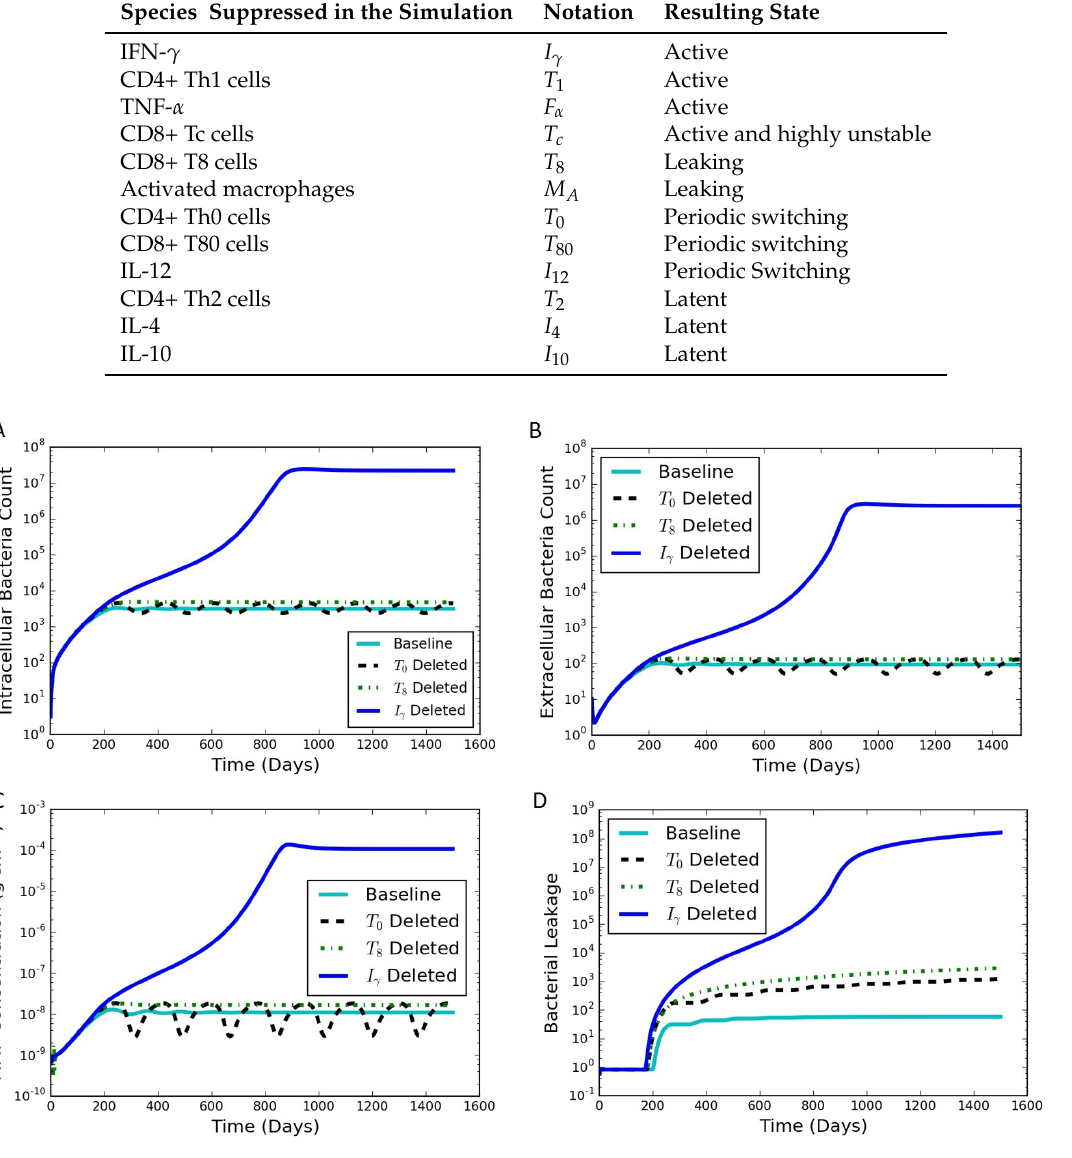
Figure 7. Simulation results of the immune system pertubation experiment where the differential equation corresponding to each of the species shown is set to be zero from day 0, one at a time while the other species follow the otherwise unmodified model equations. Perturbed responses are shown for T 0 , T 8 , and I γ (dashed, dotted, and dark solid lines, respectively) The baseline is considered to be a steady latent state (light solid line). ( A ) intracellular bacterial count vs. time; ( B ) extracellular bacterial count vs. time; ( C ) MMP concentration vs. time; ( D ) cumulative bacterial leakage vs.